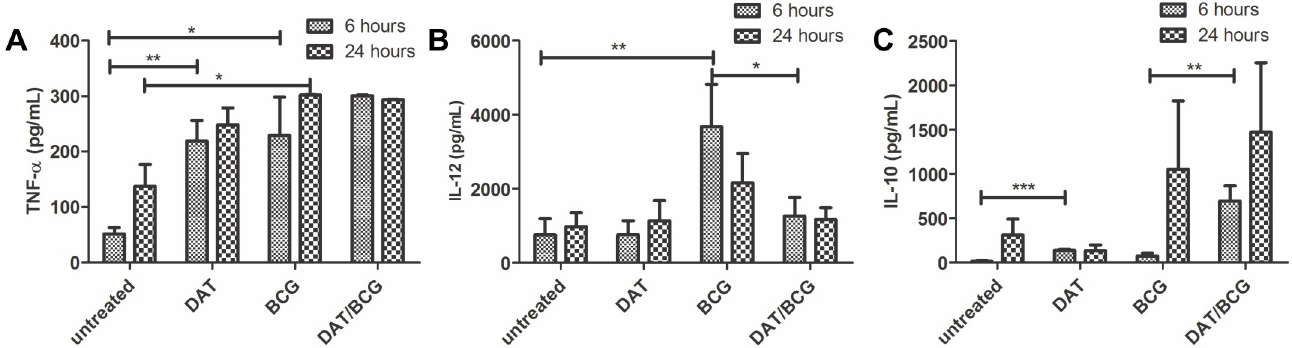
Fig 3. Di- O -acyl trehalose increases IL-10 production in dendritic cells activated with mycobacterial antigens. The production of cytokines was analyzed by ELISA in 24 h supernatants. BCG upregulates TNF- α and IL-12 (p < 0.05; unpaired t Student’s test) (A, B); the production of IL-10 was not altered. DC pretreated with DAT and then with BCG increase IL-10 production (p < 0.0001; unpaired t Student’s test) (C). DAT alone upregulated TNF- α (p < 0.05 unpaired t Student’s test) (A). The results shown were obtained in five independent